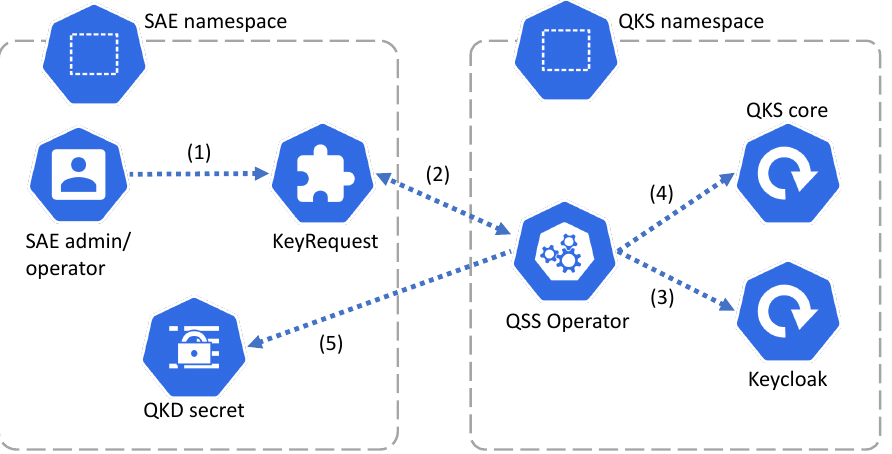
Figure 7. Key request process. SAE admin/operator creates a resource of type KeyRequest (1). QSS operator monitors resource creation (2). When it finds the new KeyRequest it starts the authentication through Keycloak (3) and forward the request to the QKS (4). At the end of the process it retrieves the QKD secret